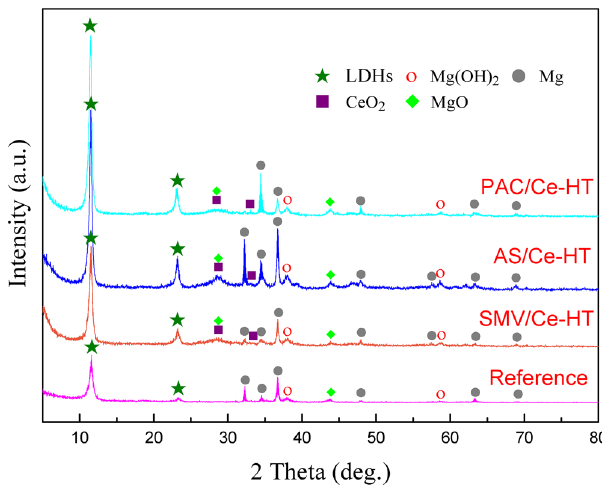
Figure 10. XRD patterns of PDC/Ce-HT, SMV/Ce-HT, AS/Ce-HT and reference